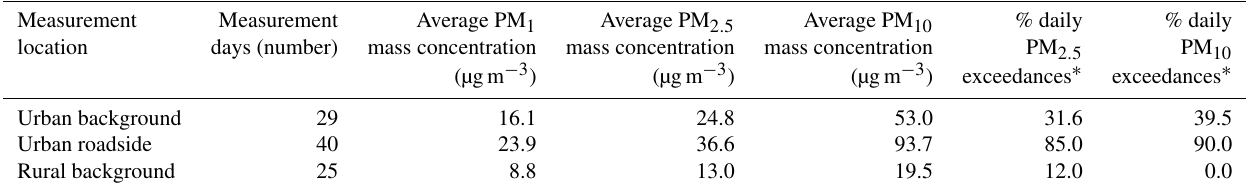
Table 1. Mean average PM mass concentrations (PM 1 , PM 2 . 5 and PM 10 ) and daily exceedances of the WHO PM guidelines (PM 2 . 5 and PM 10 ) observed at the three measurement sites during the campaign period.